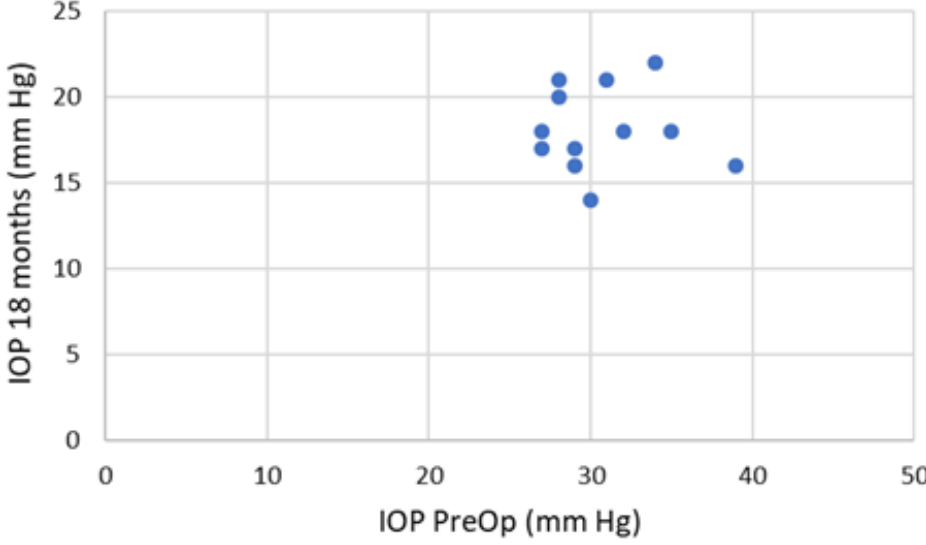
Figure 6. Box plot presentation of preoperative and postoperative intraocular pressure in mmHg. 129 All observed patients achieved 20% and more during the follow-up period. If we look 130 for the IOP below 21mmHg we have 3 patients with such achievement (Figure 7). 131